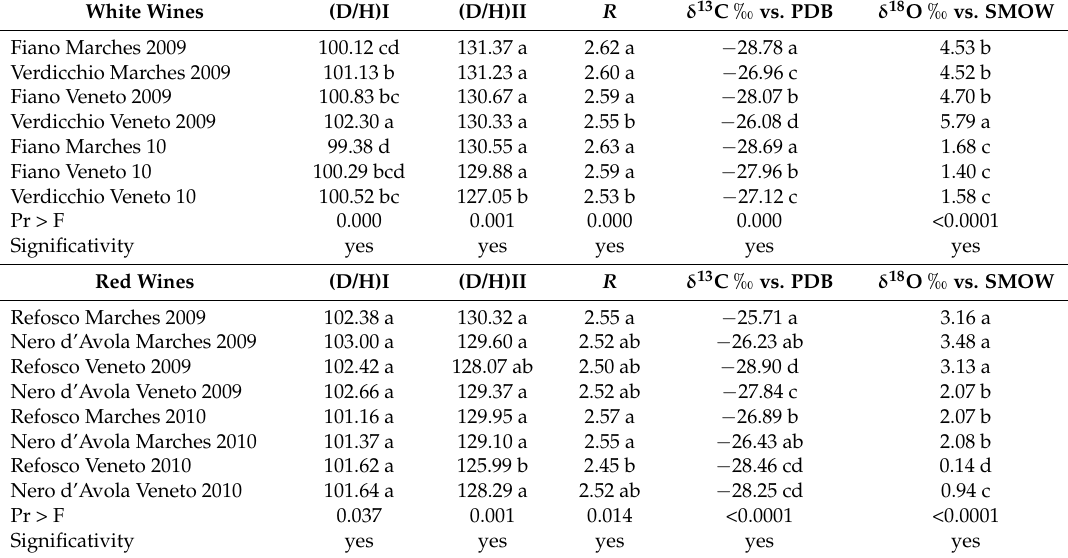
Table 3. Isotopic parameters determined in white and red wine in the two vintages (2009–2010). The isotopic ratios are expressed in δ relative to V-PDB (Vienna–Pee Dee Belemnite) for δ 13 C, (cid:104) V-SMOW (Vienna–Standard Mean Ocean Water) for δ 18 O. Different letters in the same column indicate significant differences at ANOVA and Tukey test (95%). White Wines